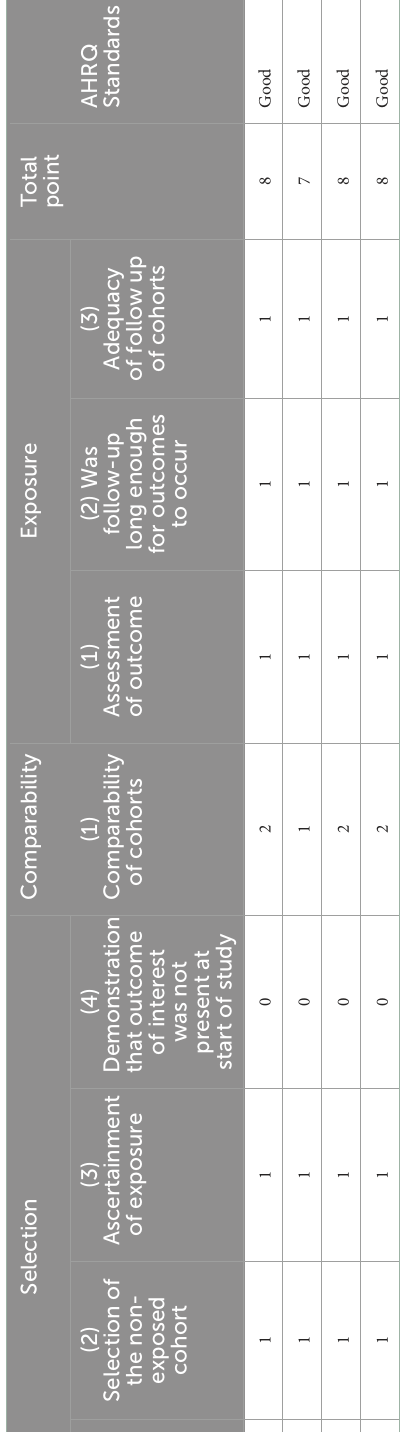
The pooled analysis revealed a statistically significant association between the vamorolone group and increased TTSTAND velocity, increased TTRW velocity, and increased TTCLIMB velocity compared with the placebo group. Similarly, the